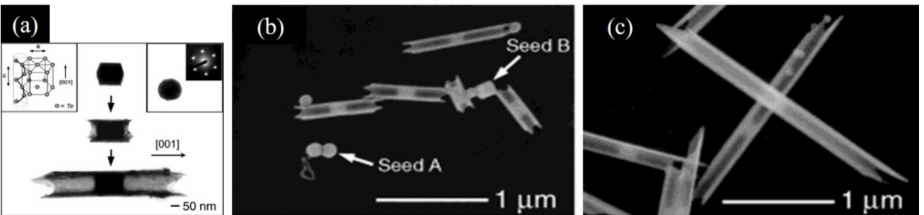
Figure 5. Te NTs that were synthesized by refluxing a solution of orthotelluric acid in ethylene glycol. ( a ) TEM images of tellurium nanotubes at three different stages of growth. The inset at the upper left corner shows an illustration of the crystal structure of trigonal tellurium that contains helical chains of tellurium atoms packed parallel to each other along the c-axis. The inset at the upper right corner gives the cross-sectional TEM image of a cylindrical seed, together with a microdiffraction pattern obtained by focusing the electron beam on this seed along the [001] direction. ( b , c ) SEM images of tellurium nanotubes at different reaction times. ( b ) 4 min, ( c ) 6 min, respectively. Several seeds, as indicated by arrows in ( b ), were still present in the early stage of this process. These seeds had two spatial orientations, with their c-axis perpendicular (type A) or parallel (type B) to the solid support. The two type seeds aggregated into a doublet during the evaporation of solvent. Reprinted with